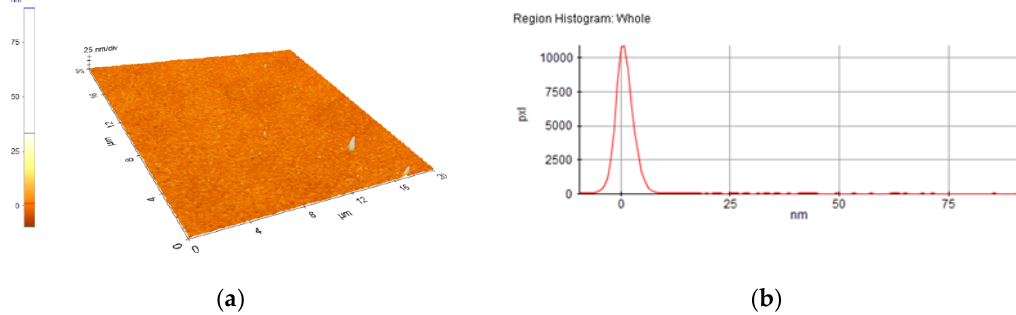
Figure 5. AFM image of 1%rGO-SiO 2 -P 2 O 5 /ITO film: ( a ) morphology, ( b ) region histogram